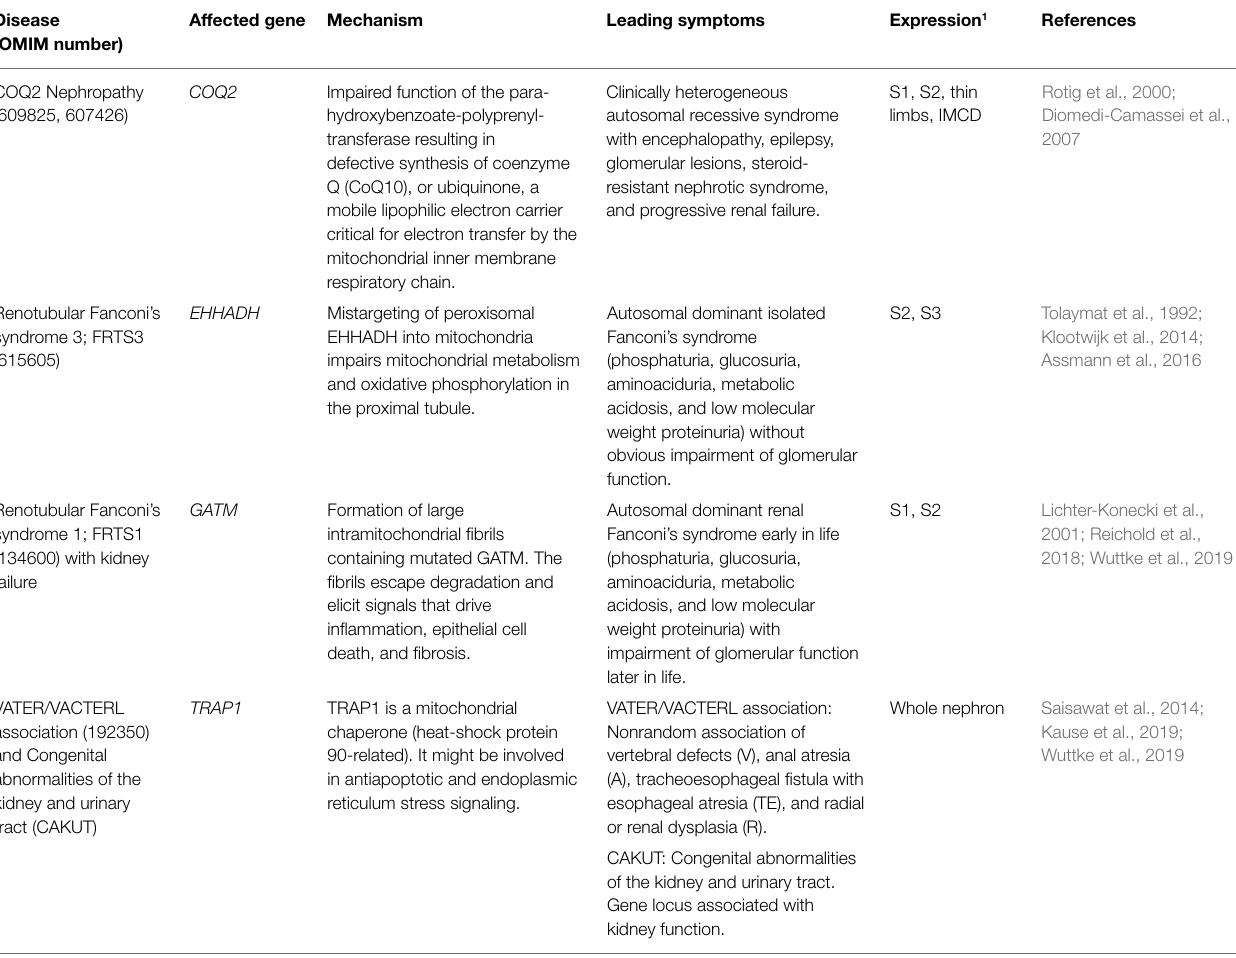
TABLE 1 | Examples of renal mitochondriopathies. Disease (OMIM